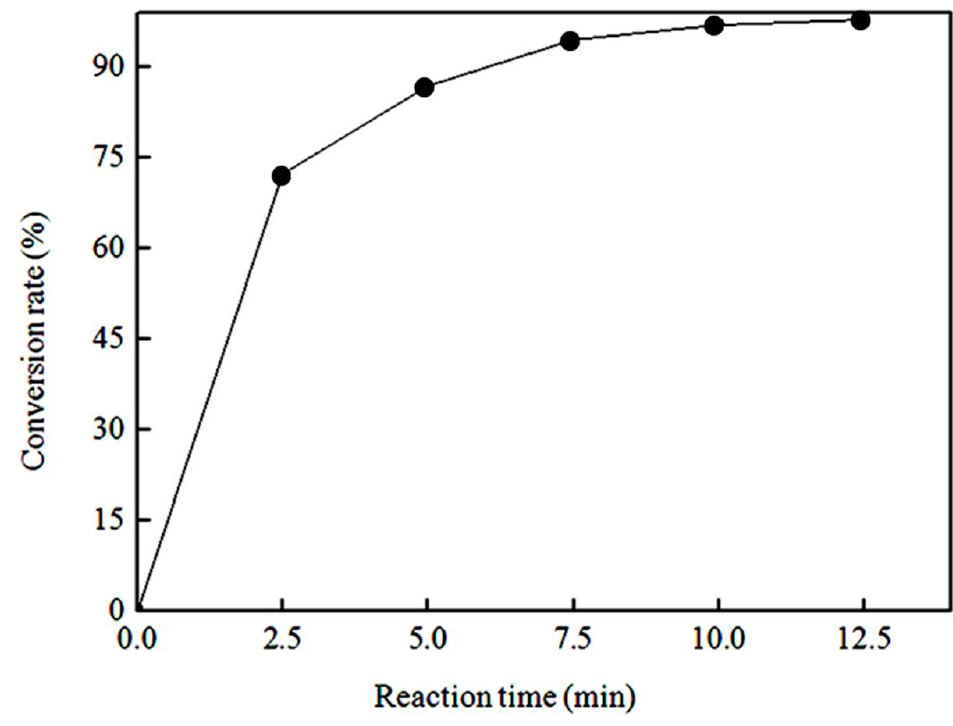
Figure 8. Effect of reaction time on the transesterification reaction.